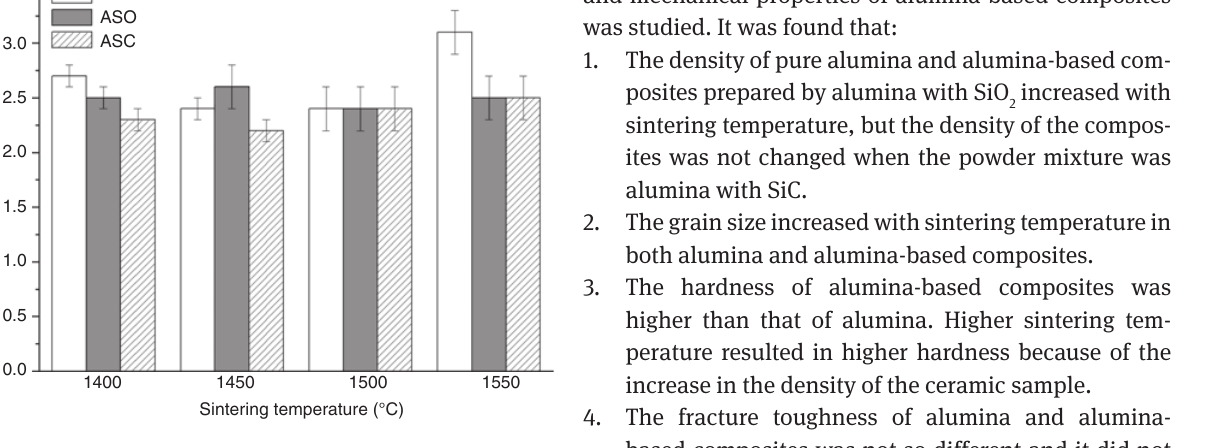
Figure 6: Graph of fracture toughness versus sintering temperature.